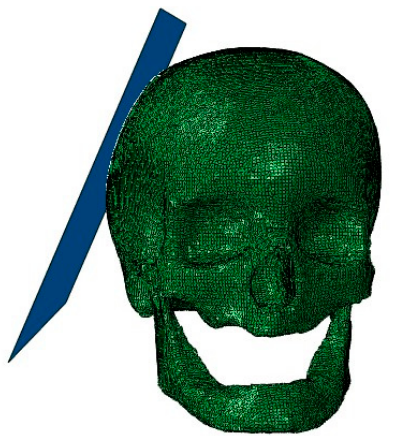
Figure 3. The assembly containing the head model and the rigid plate.